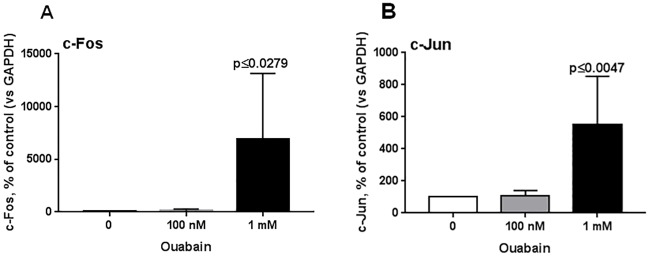
Expression of c-Fos (A) and c-Jun (B) mRNAs in cerebellum granule cells after 3 h of incubation with 100 nM or 1 mM ouabain.Data obtained in 5 independent experiments are presented as the mean ± SD. Gene expression in the absence of ouabain was taken as 100%.